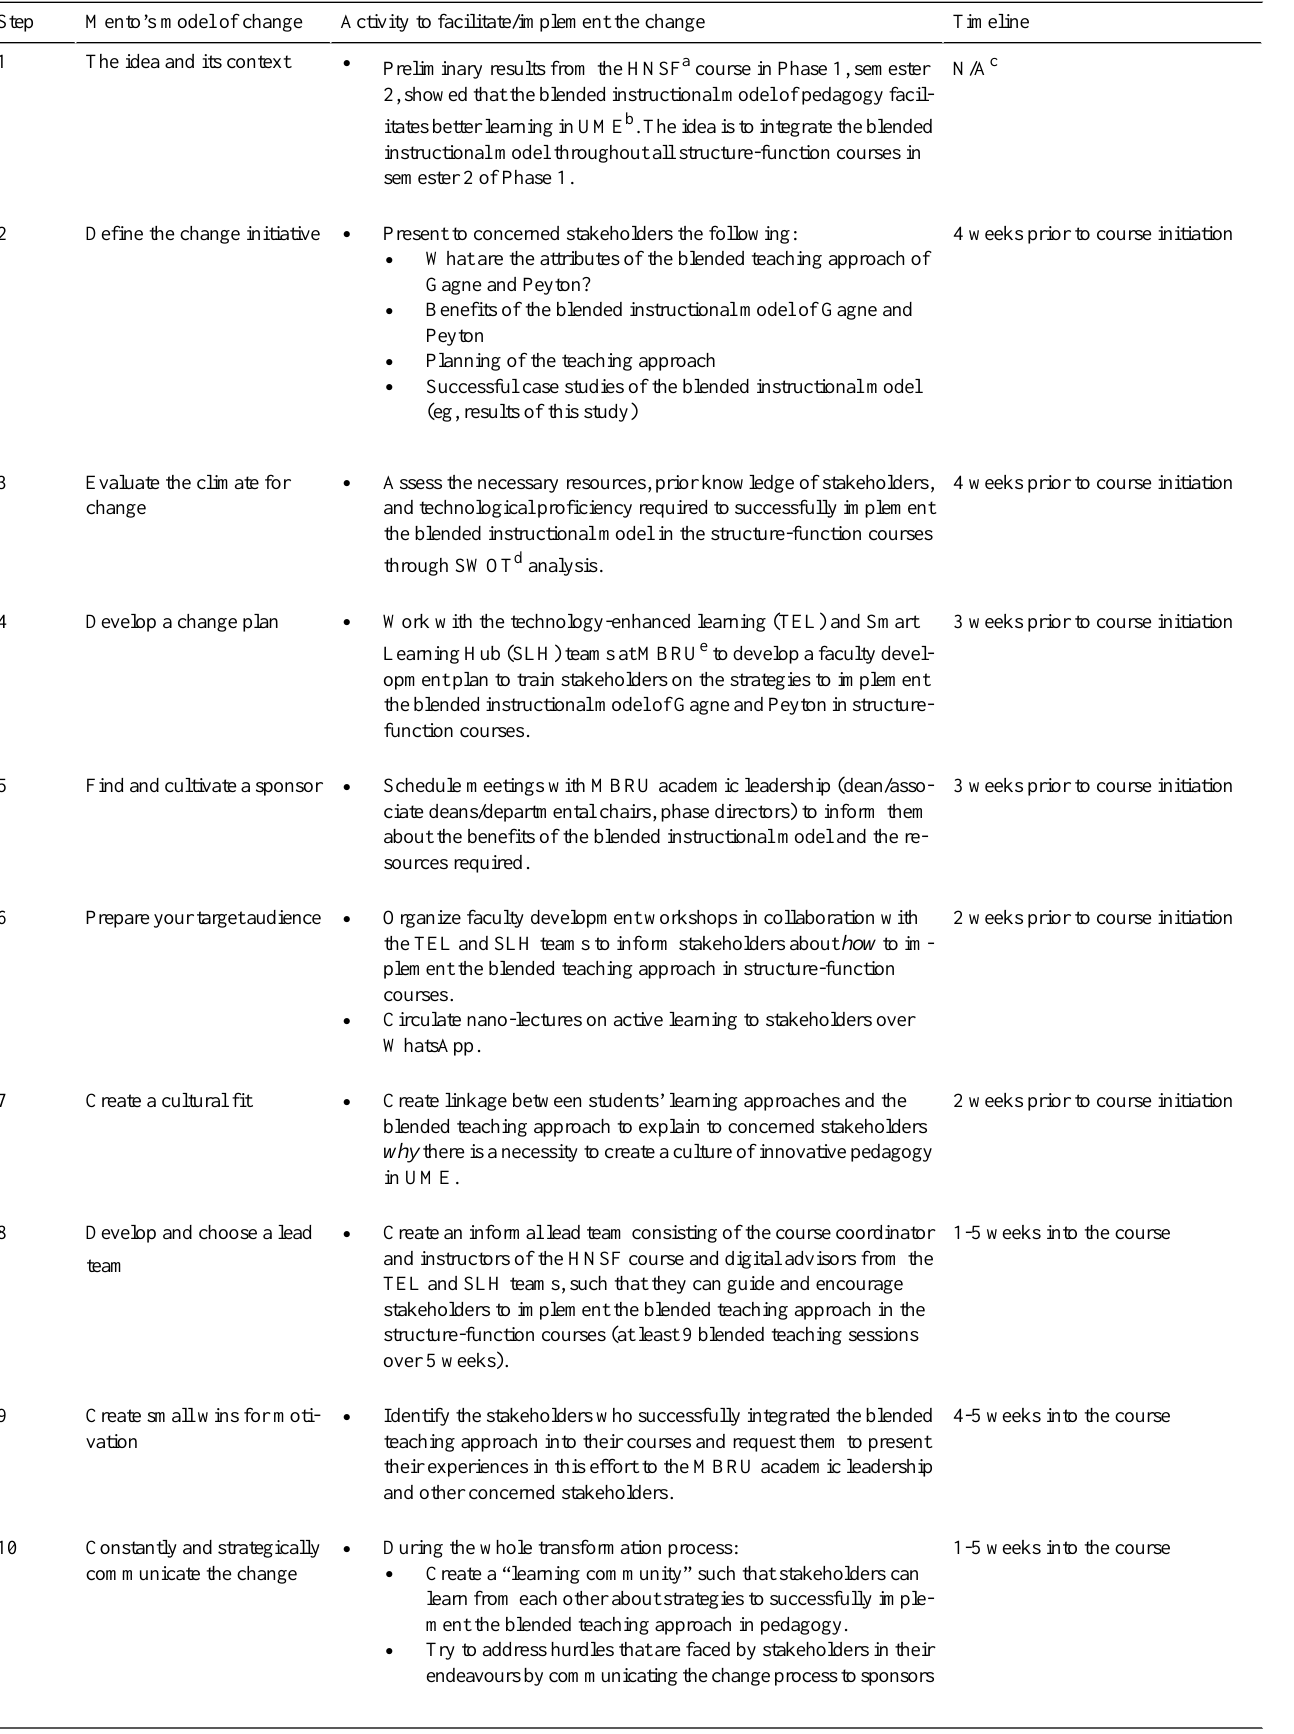
Table 2. Guidelines outlining the activities and timeline corresponding to each step of Mento’s change management model for the integration of a blended Gagne-Peyton instructional model in all structure-function